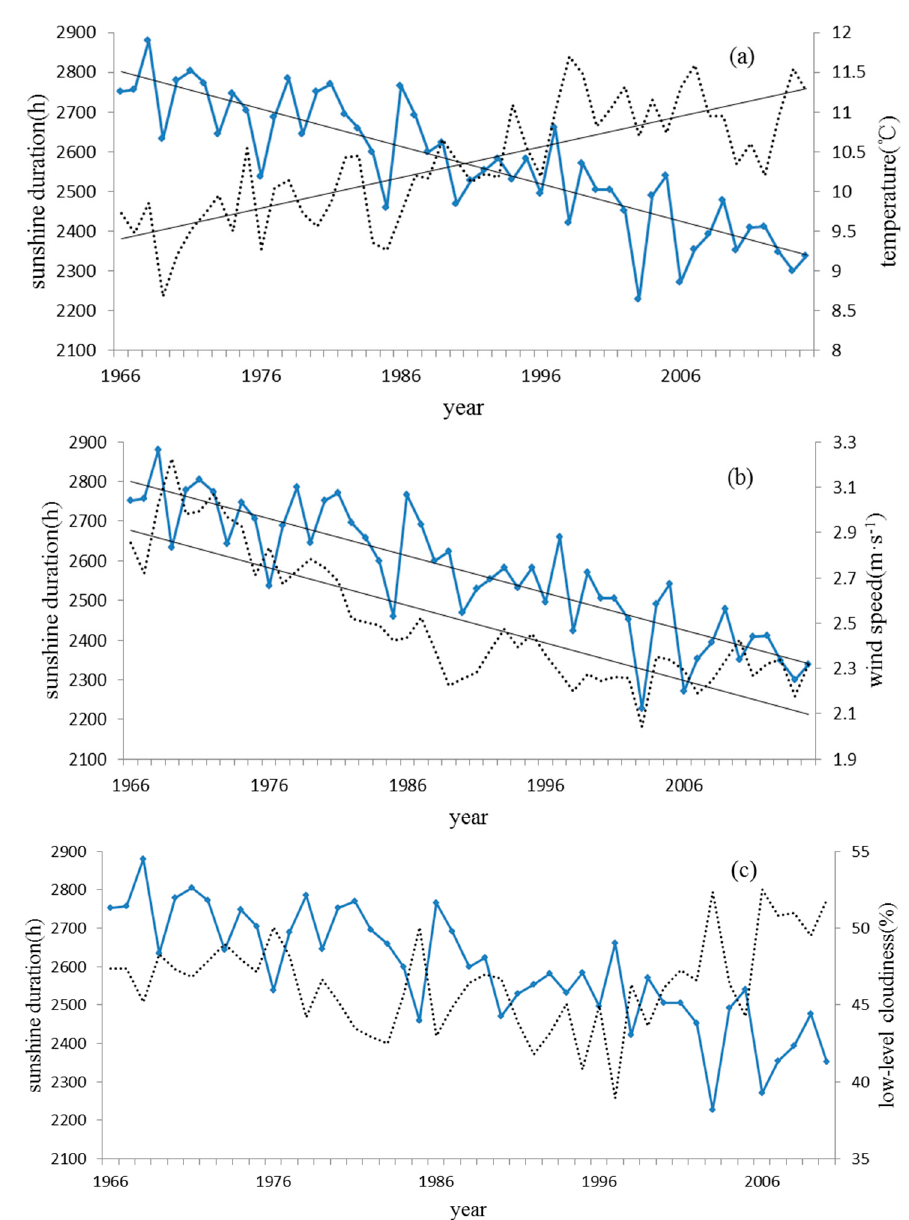
Figure 9. Relationship of sunshine duration (blue line) with ( a ) temperature (dotted line), ( b ) wind speed (dotted line ) and ( c ) low-level cloudiness (dotted line).